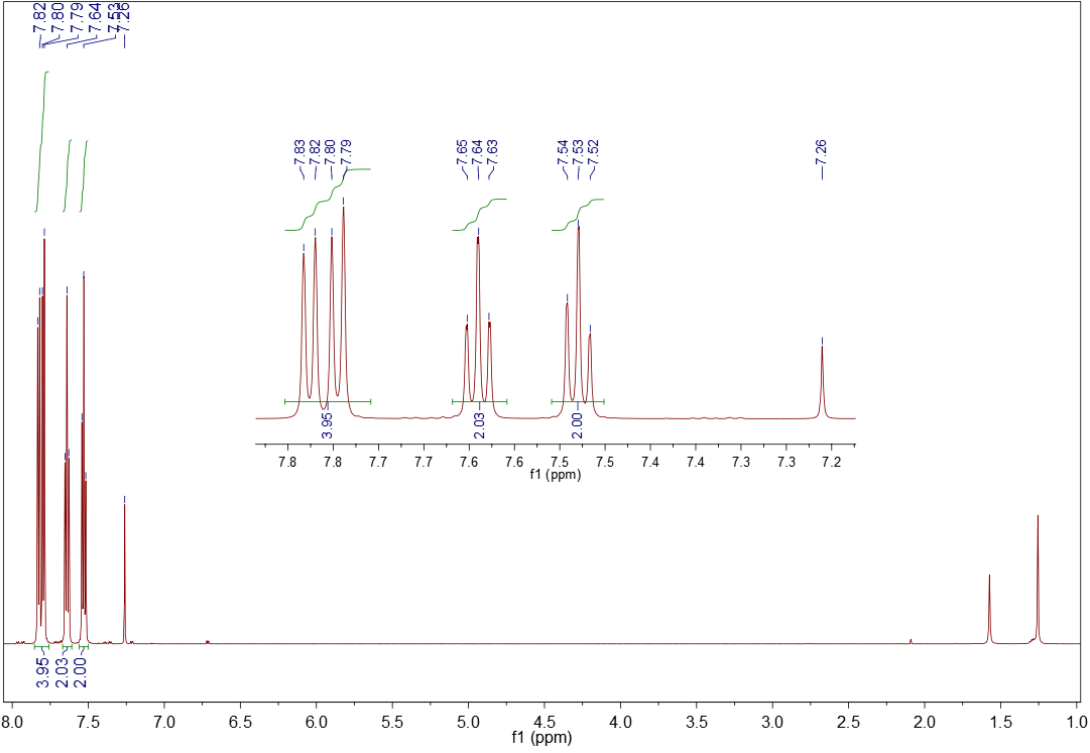
Figure 7. 1 H NMR spectrum of sediment precipitated from the surrogate LGO. Sample of 10 mg in 0.7 mL deuterated chloroform, 600 MHz. (CDCl 3 , 600 MHz) δ (ppm): 7.85 –7.75 (m, 4H), 7.63 (t, J = 7.6 Hz , 2H), 7.52 (t, J = 7.6 Hz , 2H). Its spectrum is shown in Figure 8.